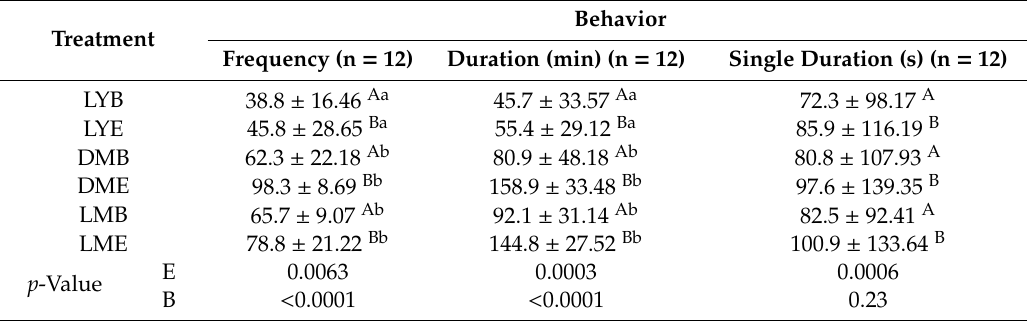
Table 2. Nest-building behavior of prepartum sows.